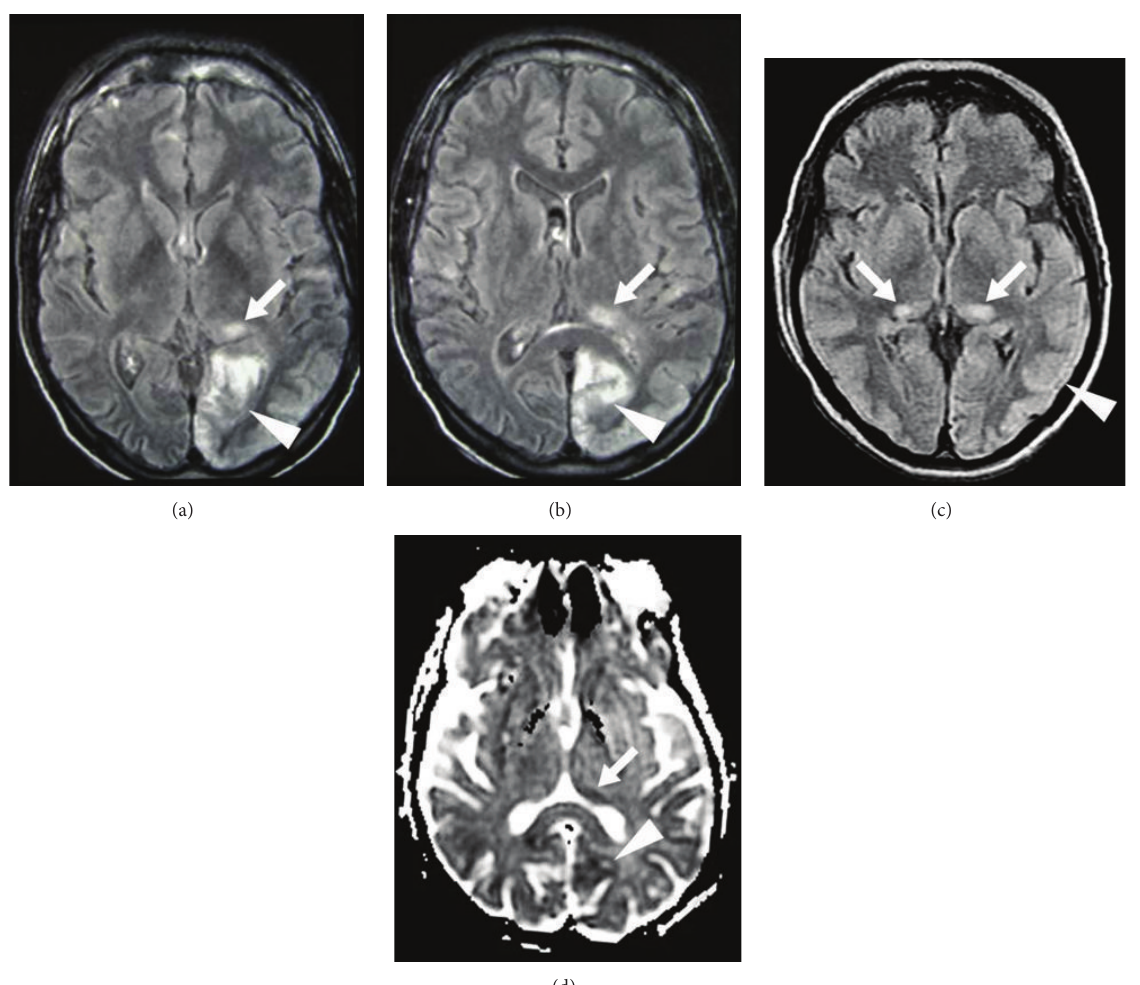
Figure 25: Peri-ictal thalamic lesions (arrows) following status epilepticus in patient 1 (a and b) with partial occipital status epilepticus related to MELAS in the left occipital lobe (arrowheads on a and b) all seen as hyperintensity on FLAIR imaging and in patient 2 (c and d) with generalized status epilepticus with also left occipitotemporal cortical signal changes due to the seizures seen as hyperintensity on FLAIR imaging (c) and as hypointensity on ADC map